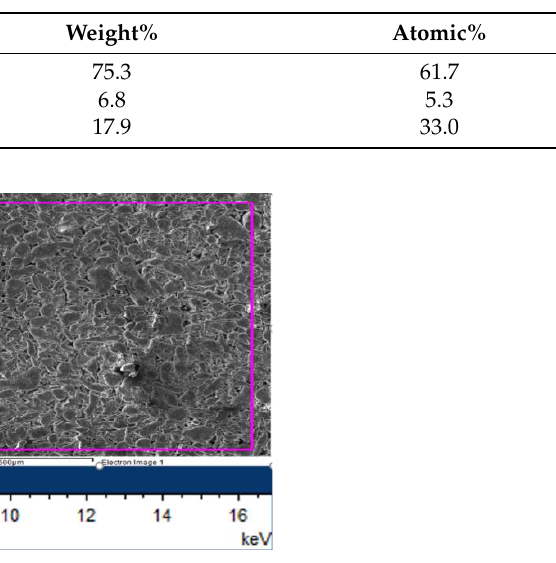
Table 4. List of elements found in the Al + 5%SiC reinforced composites.